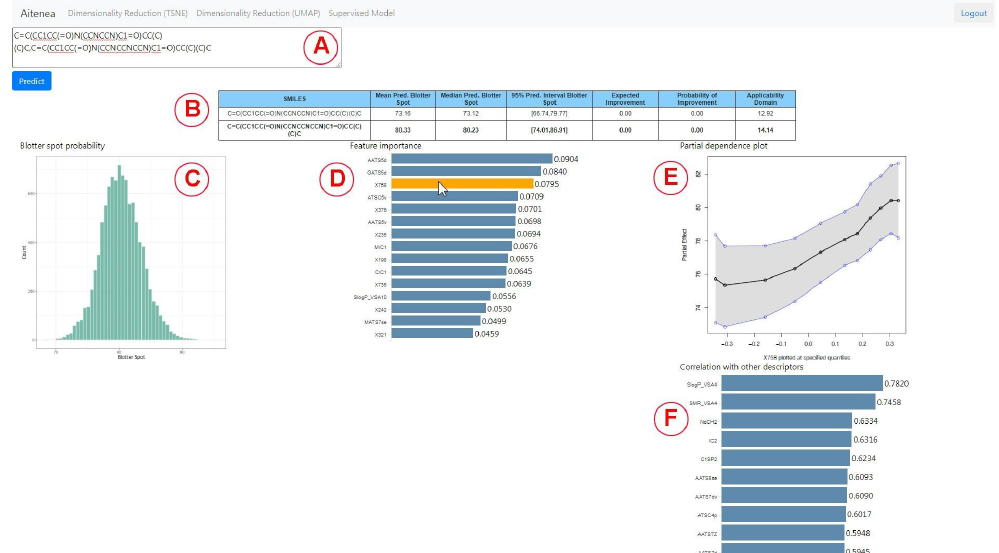
Figure 2. Interface for the model using BART. The table summarizes the performance of the entered molecules ( A , B ). The histogram shows the posterior probability for the compound clicked from the table ( C ). Feature importance, a partial dependency plot and correlation of a descriptor with other descriptors are also shown ( D – F ). For instance, we can see in the partial dependence plot that the Blotter spot value tends to increase for larger values of the selected variable (the embedding X758), while the correlation bar chart shows that this embedding correlates highly with the descriptor SlogP_VSA4.